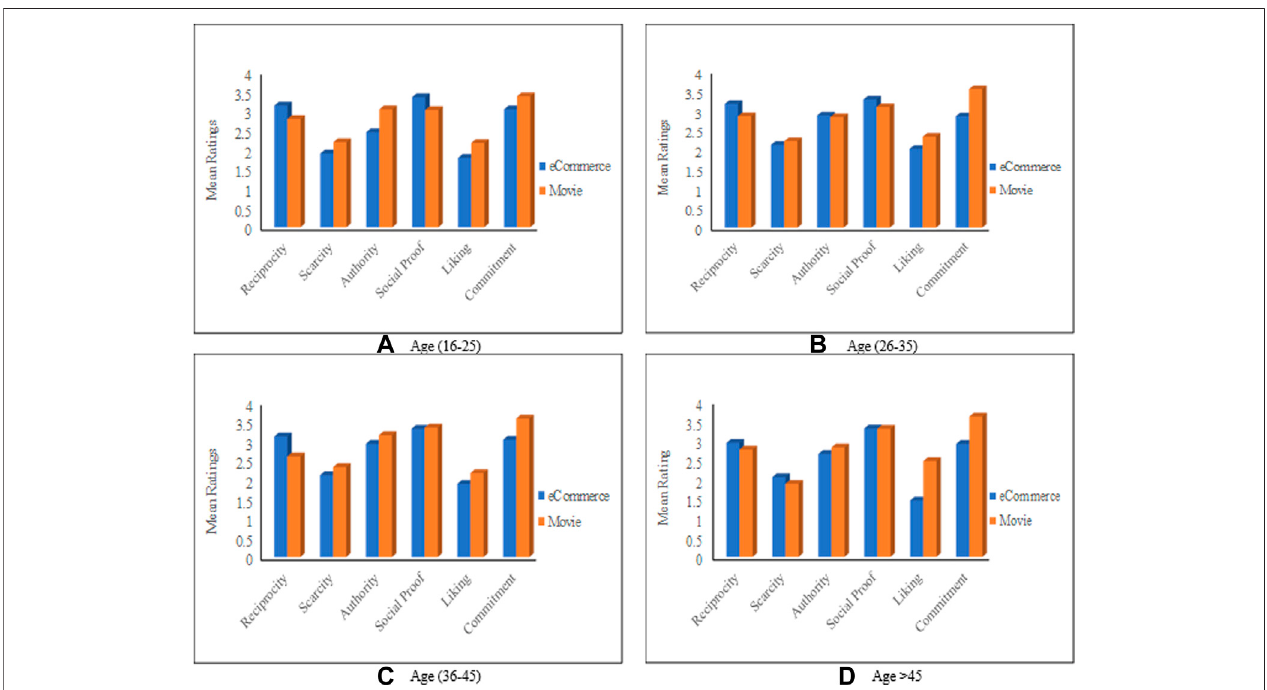
FIGURE 8| Mean rating based on the age and the application domain. (A) fi rst age group (16-25 years old), (B) second age group (26-35 years old), (C) Third age group (36-45 years old), (D) Fourth age group (45 years and older).